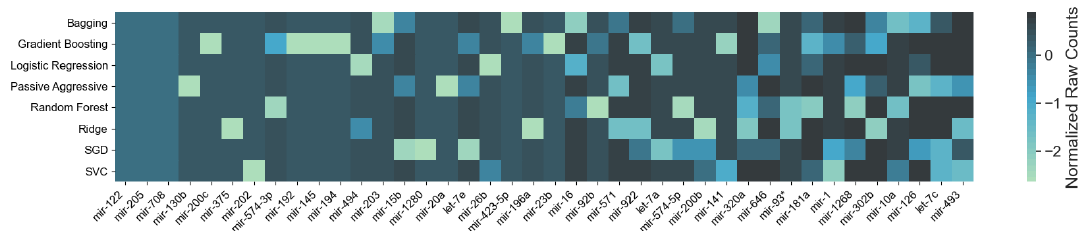
Figure 1. Feature importance by classifier: On the horizontal axis, the top features are reported, following their ensemble ranking. The intensity of the color in each square represents the frequency of appearance of that particular feature in the 10 instances of the same classifier produced by cross-validation; the darker the color, the more frequent the appearance of that feature among the most important. It is noticeable how different classifiers rank features differently. For this figure, we report the top 42 features only for visualization purposes.